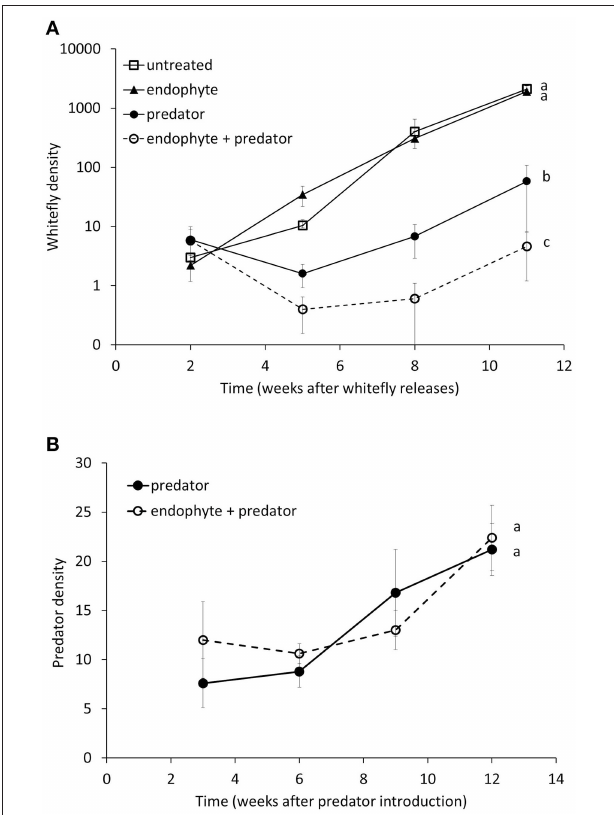
FIGURE 1 | Population dynamics of (A) the greenhouse whitefly Trialeurodes vaporariorum and (B) the predator Macrolophus pygmaeus on tomato plants treated with the endophyte Fo162, the predator M. pygmaeus , both, or none of them (untreated). Predators were added 1 week and the endophyte inoculations were done 2 and 3 weeks prior to the whitefly release, respectively. Data shown are the mean ( ± SE) (Log) densities of juvenile whiteflies per 6 leaflets and predator densities per plant. Different letters next to the curves indicate overall significant differences among treatments (Fisher’s LSD-tests, p <